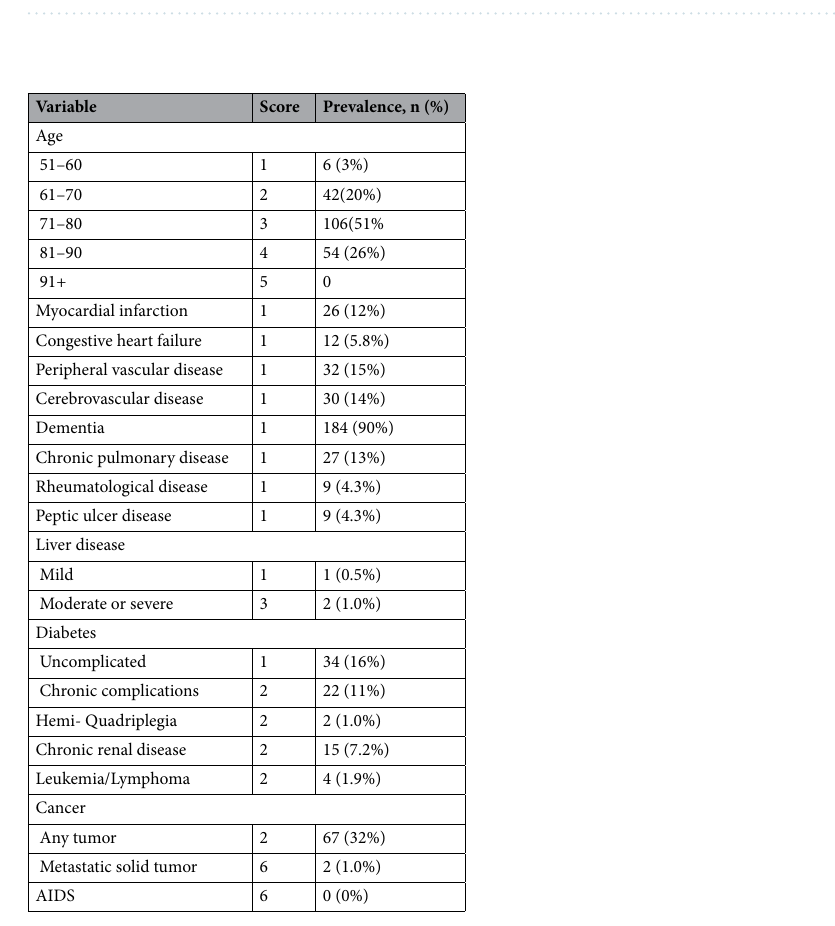
Table 1. Clinical Scores.